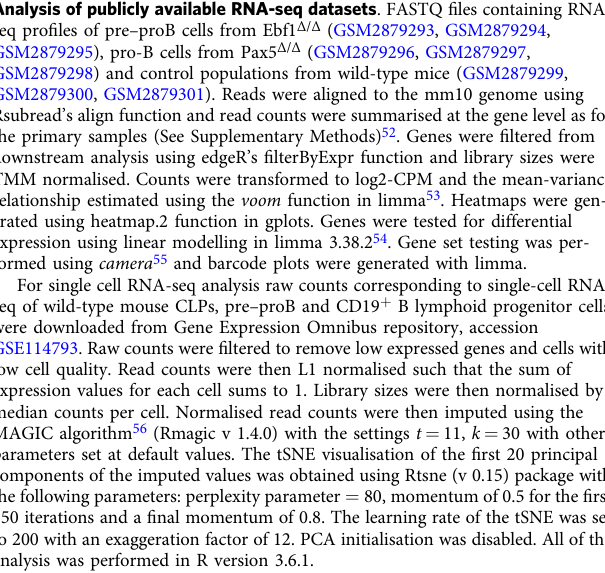
tary Table 4 for antibody dilutions and catalogue numbers for commercial anti- bodies. FACS-Gal analysis was performed using warm hypotonic loading of fl uorescein di β -D-galactopyranoside (Molecular Probes) on single cells 50 followed by immunophenotyping using relevant surface antigens as de fi ned in Supple- mentary Table 1. Cells were analysed using a LSR II or FACS Canto fl ow